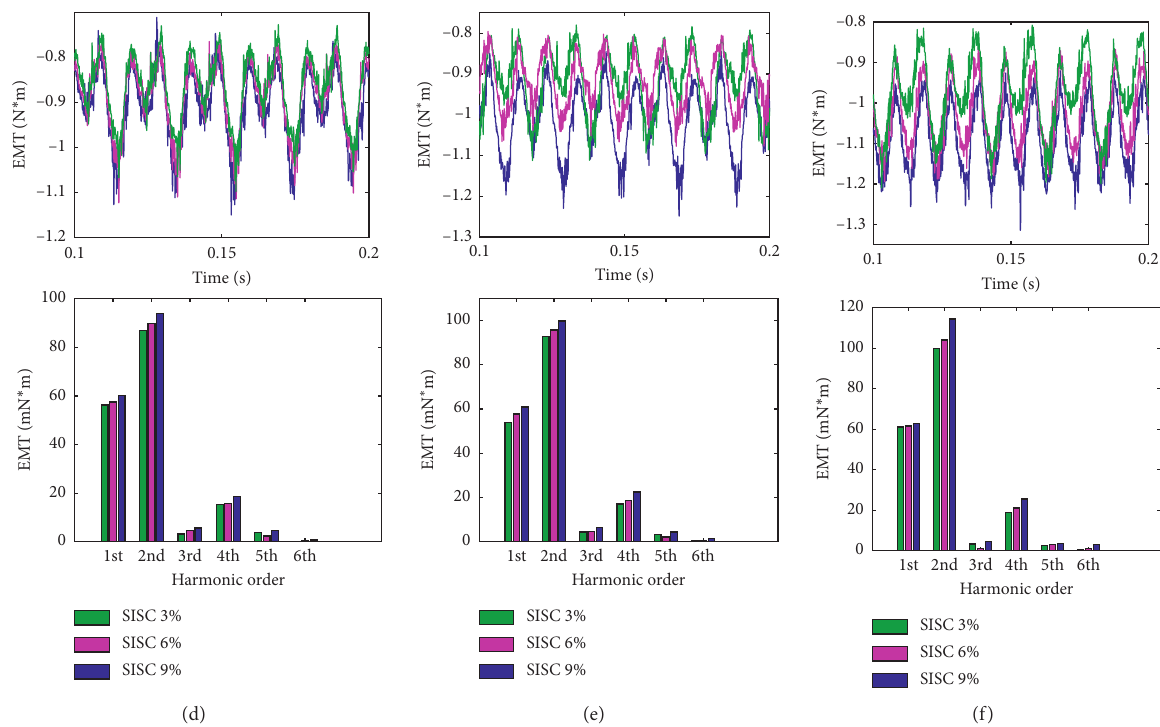
Figure 13: EMTcurves and spectra in CF cases by experiment: (a) SISC 3% and different SAGE degrees, (b) SISC 6% and different SAGE degrees, (c) SISC 3% and different SAGE degrees, (d) SAGE 10% and different SISC degrees, (e) SAGE 20% and different SISC degrees, and (f) SAGE 30% and different SISC